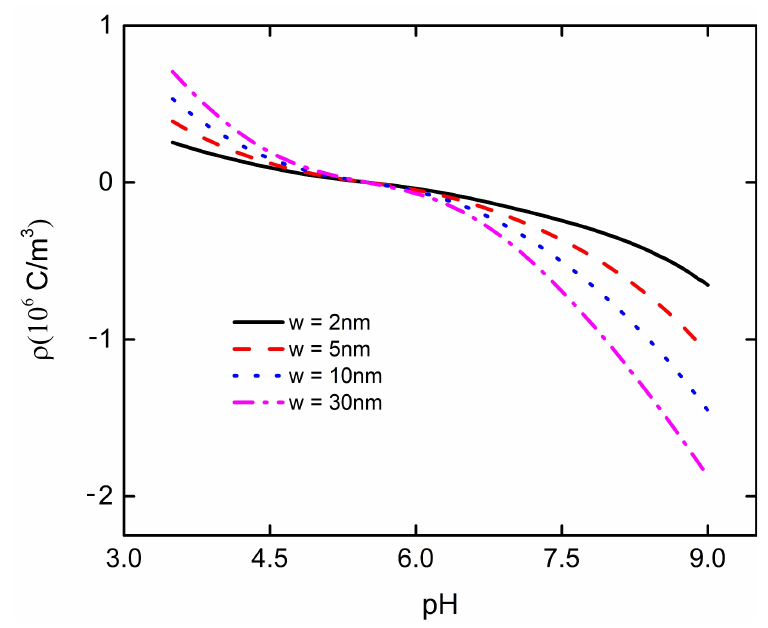
Figure 7. The change curve of total charge density with pH in the PE brush layer at the bottom of nanoparticle with di ff erent distances between particle and plate at C KCl = 1